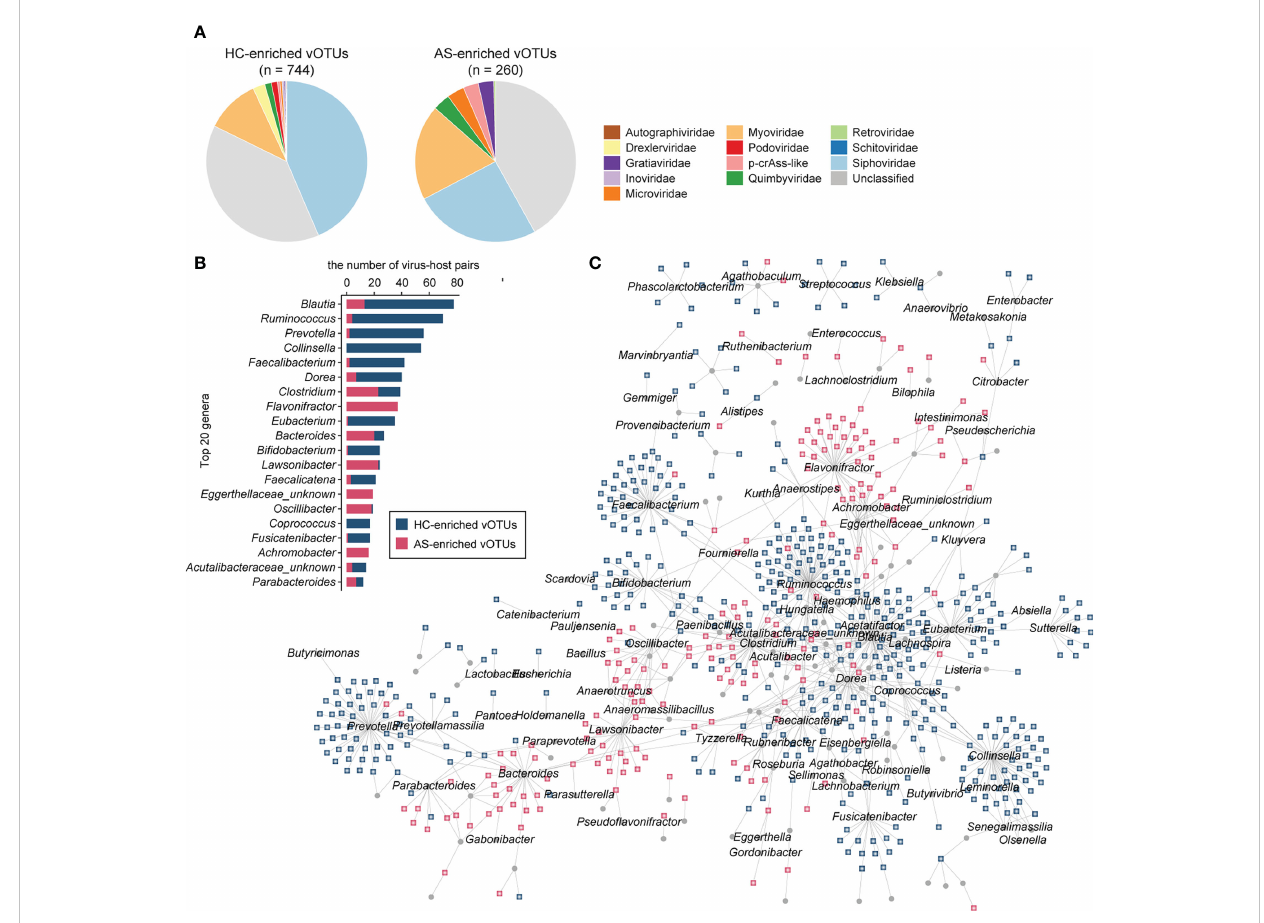
FIGURE 3 AS-associated gut viral signatures. (A) Taxonomic distribution of AS-enriched and HC-enriched vOTUs. (B) Distribution of prokaryotic hosts of AS- associated vOTUs. (C) Network showing vOTUs and corresponding prokaryotic